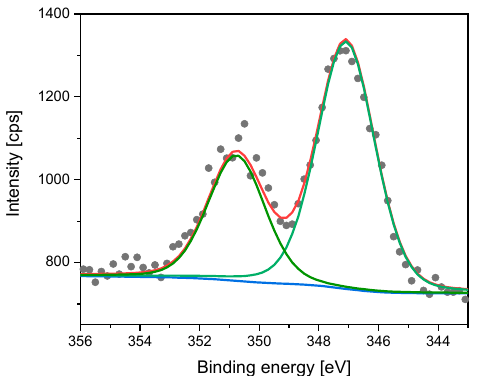
Figure 2. ToF-SIMS chemical imaging of the POEGMA-grafted brush coatings before ( a , b ) and after ( c , d ) mineralization.